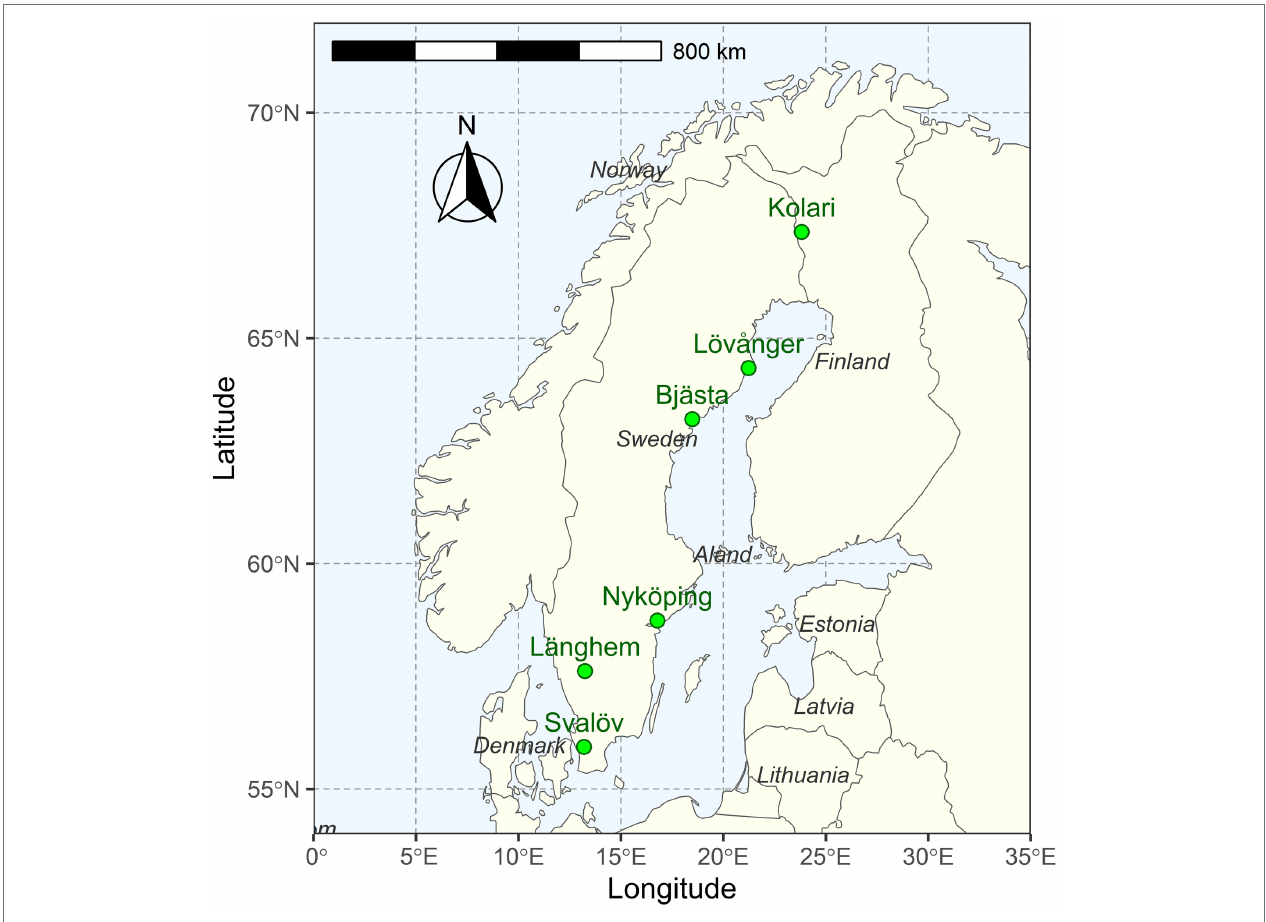
FIGURE 1 | Locations of the study sites in Northern